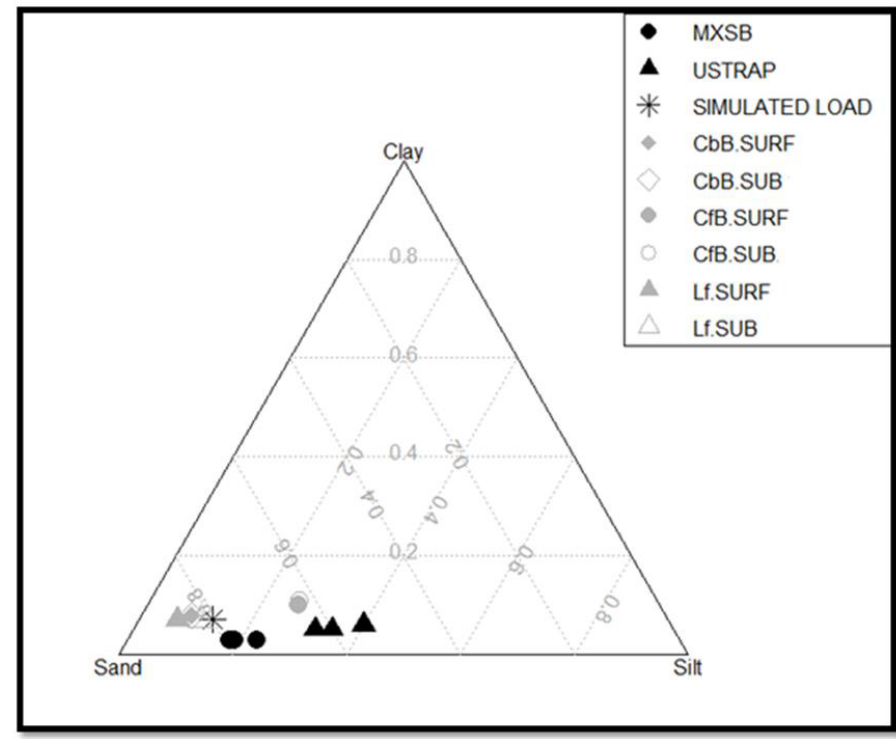
Figure 2. Ternary diagram of the mean grain sizes observed in the surface (SURF) and subsurface (SUB > 50 cm depth) soil layers for each soil type in the watershed, and in the sediment traps in Mexico (MXSB) and at the outlet in USA